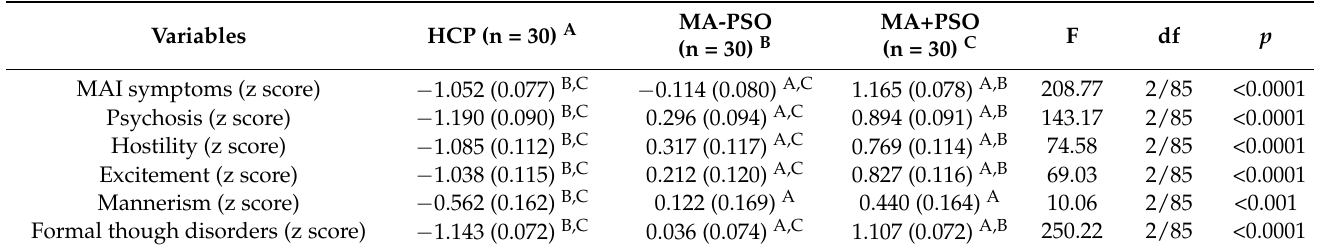
Table 2. The clinical rating scales scores in healthy control participants (HCP) and patients with methamphetamine abuse (MA) classified into those with (MA+PSO) and without (MA-PSO) increased psychotic symptoms and oxidative stress (PSO).